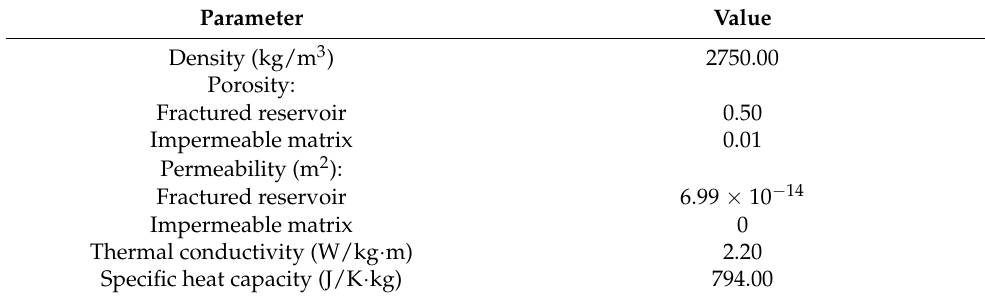
Table 2. Petrophysical parameters.